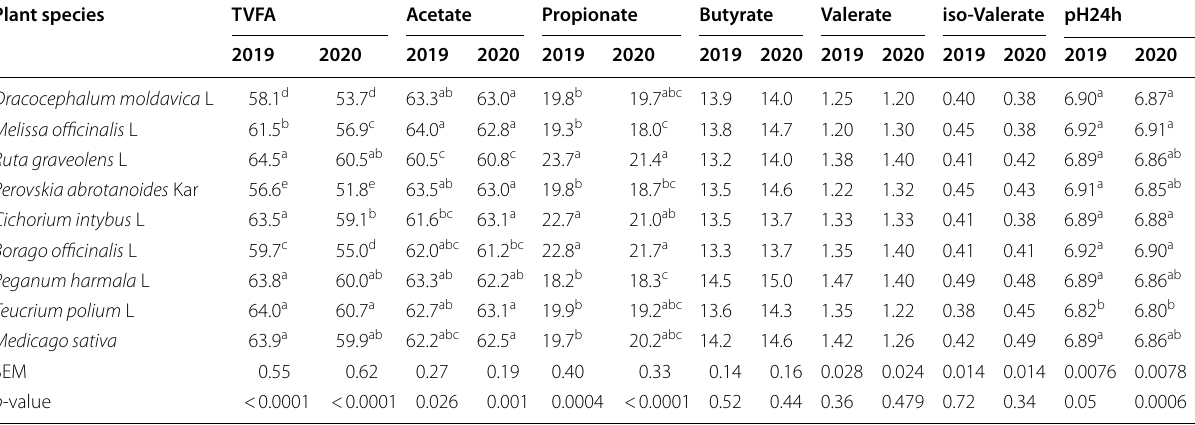
Means with different letters among the same row indicate significant differences according to the p -value presented TVFA total volatile fatty acids, SEM standard error of the mean